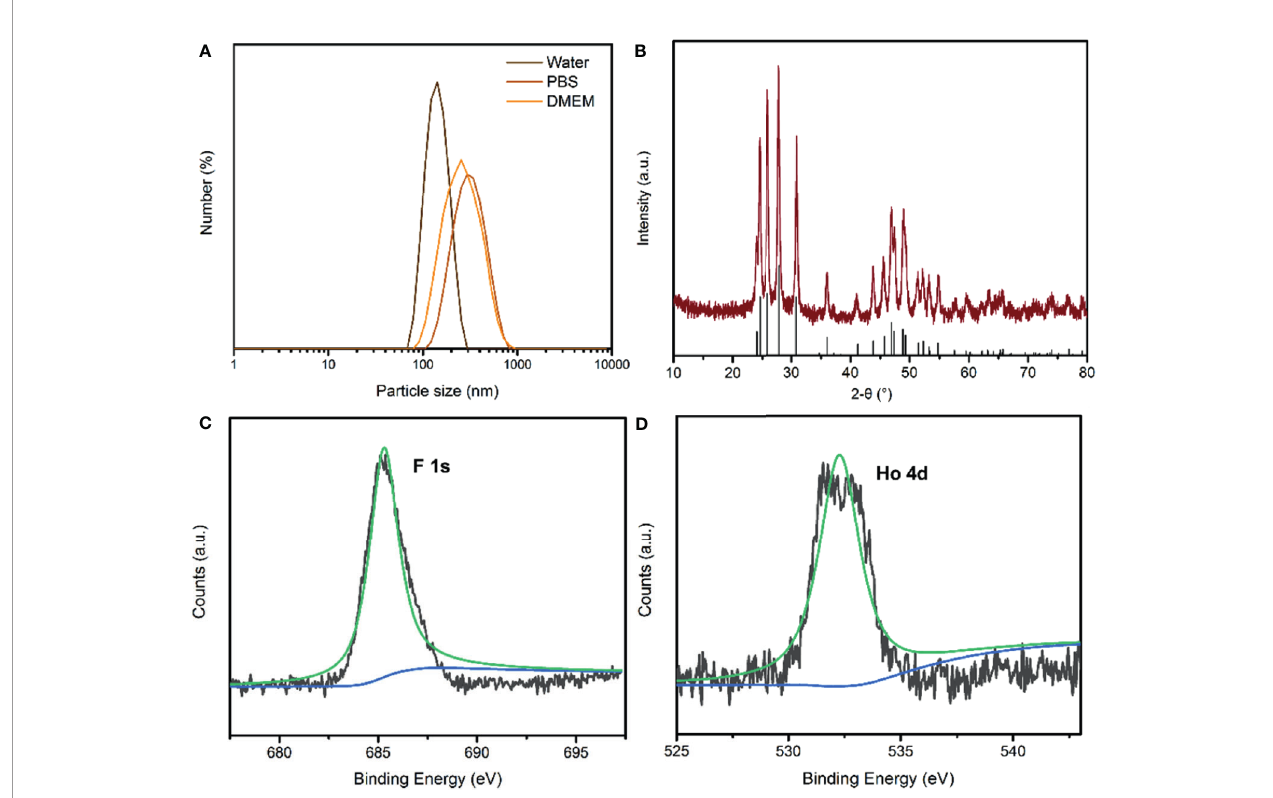
FIGURE 2 | (A) The dynamic light scattering (DLS) of PEG-HoF 3 NPs; (B) XRD pattern of PEG-HoF 3 NPs; (C, D) Higher-resolution XPS spectra of Ho 4d and F1s, respectively.